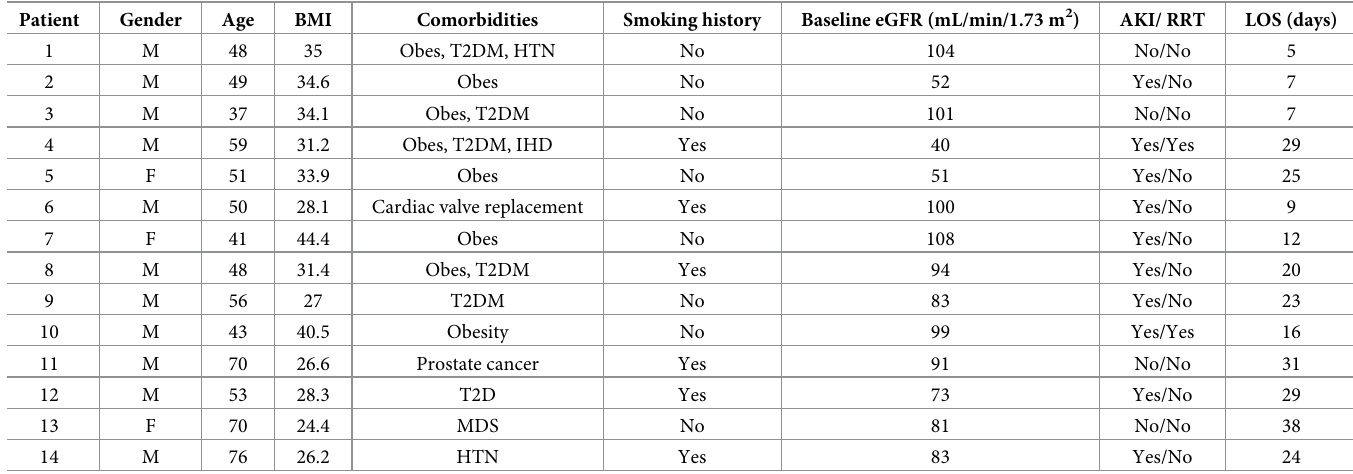
Table 1. Patient characteristics.